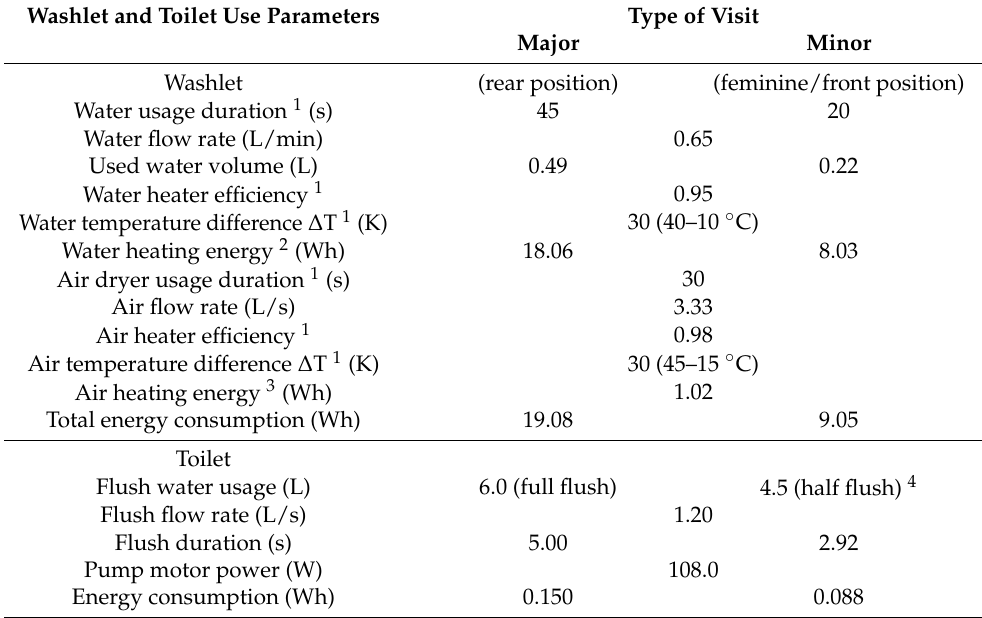
Table 4. WashOne water and energy use (washlet and toilet) per type of visit (major or minor). Source: Developed by the authors using data collected by the author affiliated with OLI and from the